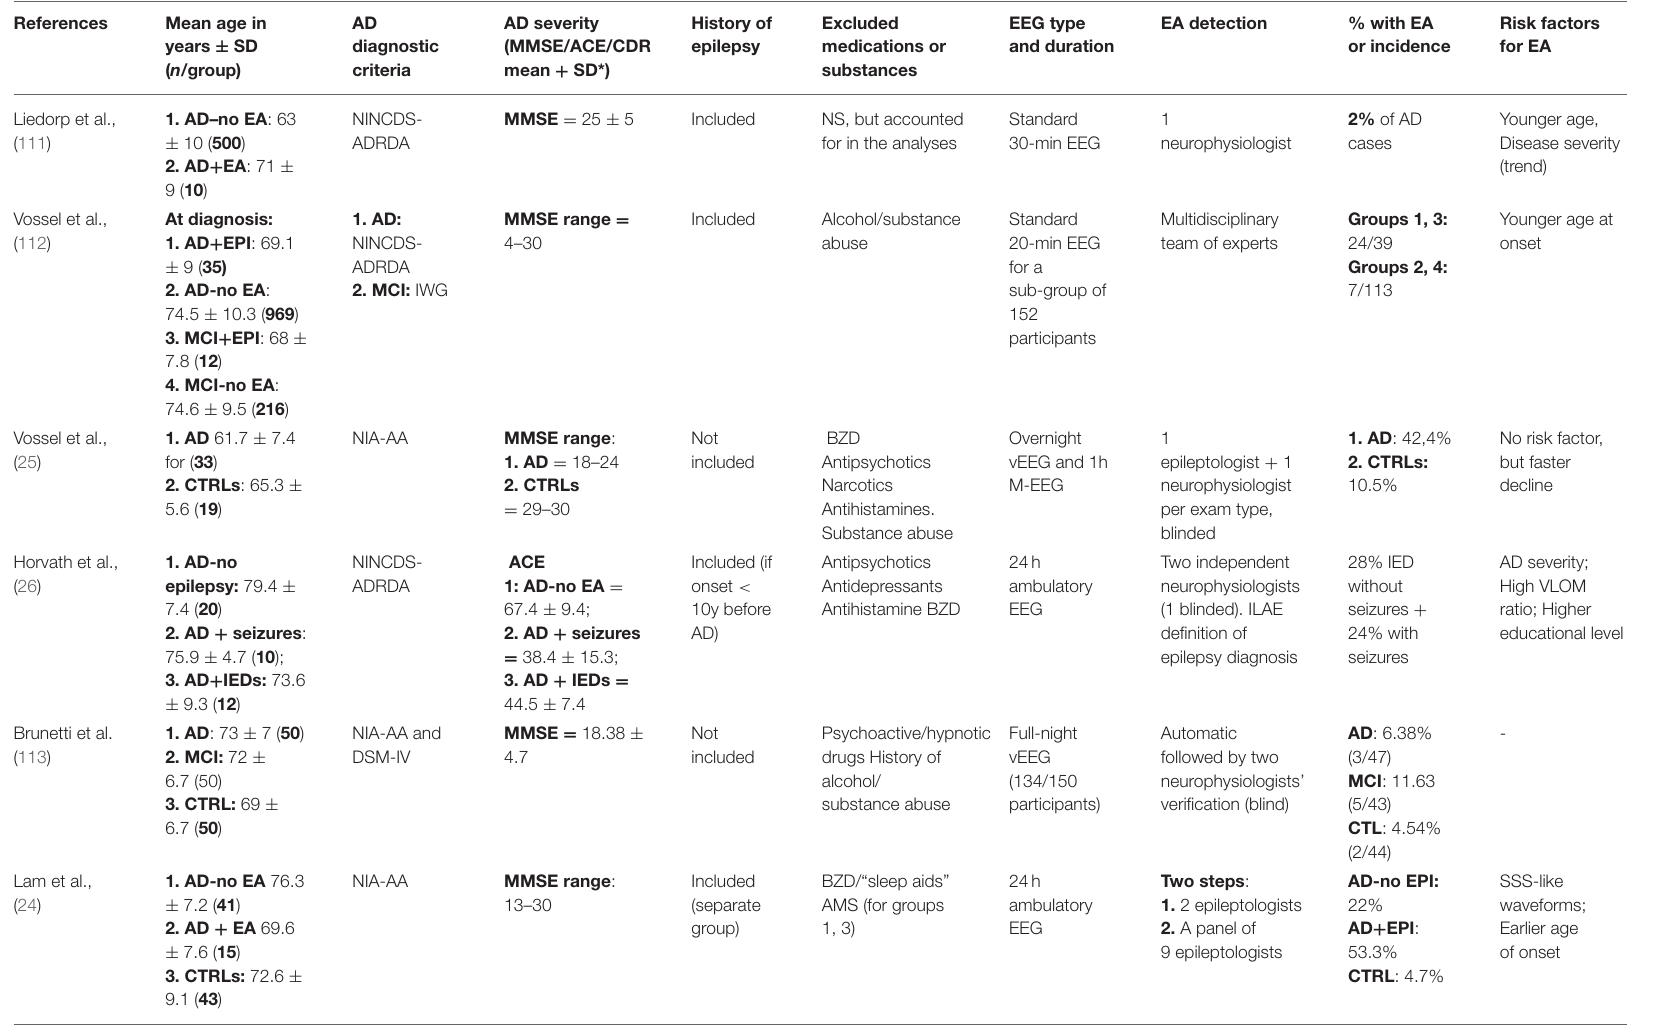
TABLE 1 | Main inclusion criteria and results of clinical studies exploring the prevalence of epileptic activities in AD